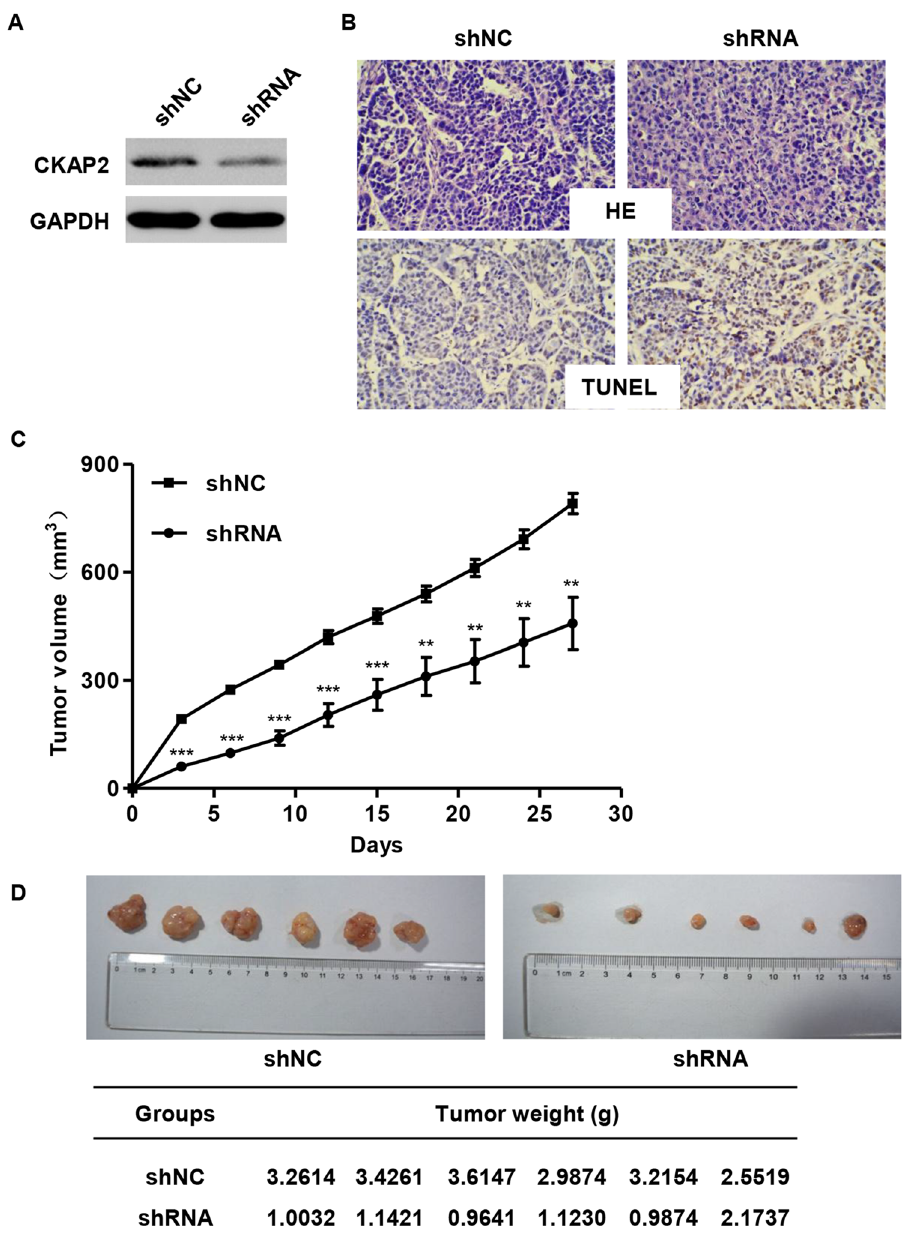
Figure 3. Effects of CKAP2 on tumor growth in vivo . ( A ) Expression of CKAP2 was measured by Western blot. ( B ) Tumors developed from pLKO.1-EGFP-CKAP2 shRNA infected C-33A cells showed higher TUNEL- positive cells than tumors developed by pLKO.1-EGFP-shNC cells. ( C ) The tumor volume was calculated every three days after injection of C-33A cells with pLKO.1-EGFP-CKAP2 shRNA or pLKO.1-EGFP-shNC. ( D ) Tumor weights are represented as means of tumor weights. ** P < 0.01, *** P <